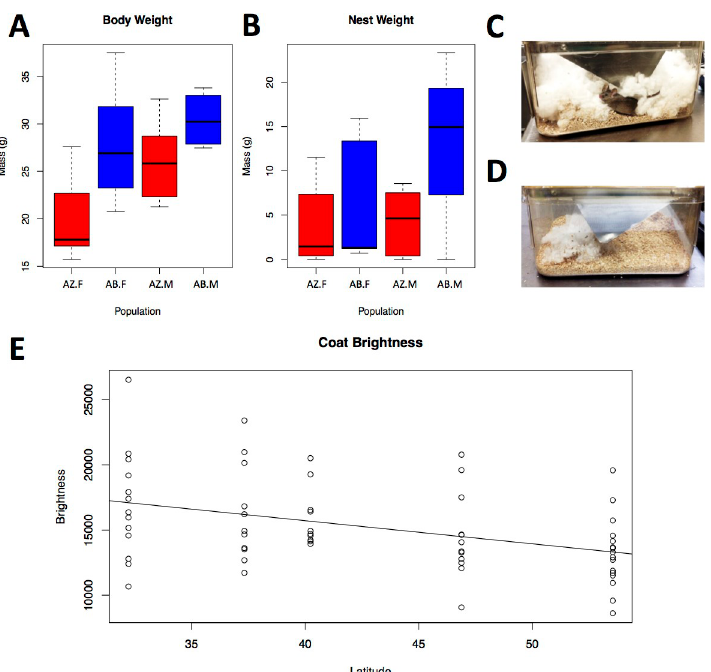
Fig 3. Phenotypic variation in lab-reared and wild-caught mice. A) Body mass of fifth-generation laboratory-reared female (F) and male (M) mice from Arizona (red) and Alberta (blue); B) mass of nesting material used by fifth- generation laboratory-reared female (F) and male (M) mice from Arizona (red) and Alberta (blue) in a 24-hour period; C) a typical large nest built by a mouse from Alberta; D) a typical small nest built by a mouse from Arizona; E) brightness of the dorsal fur of 50 wild-caught mice as measured by a spectrometer. Brightness is measured as the total area under the average reflectance curve from 300–700 nm in arbitrary units.